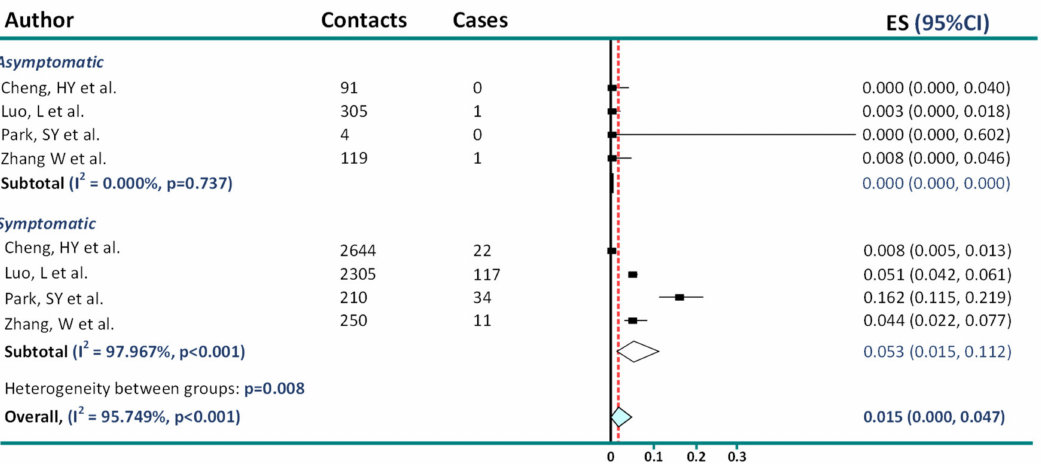
Figure 1. Reanalysis of data on asymptomatic and presymptomatic transmission